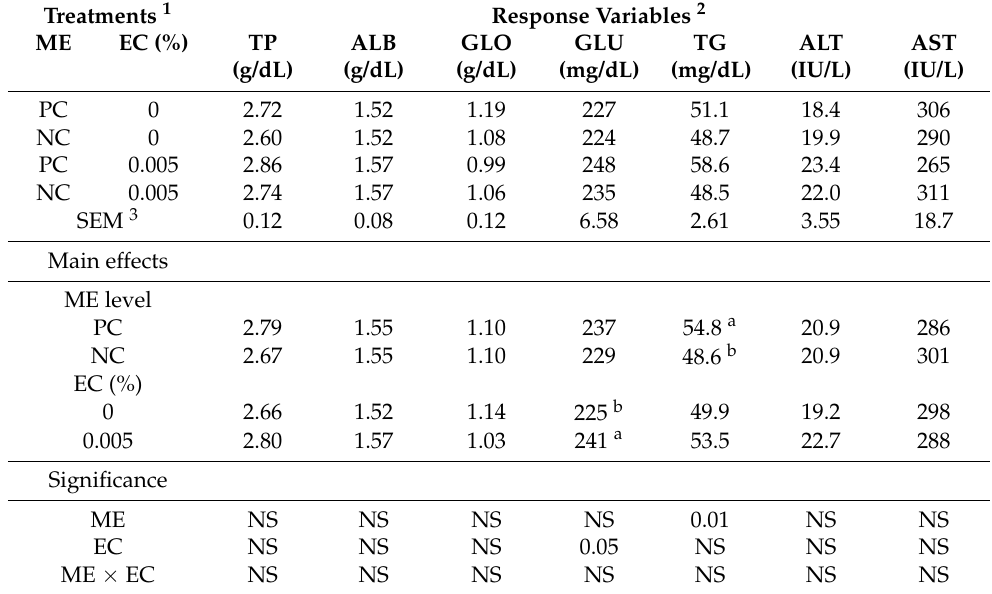
Table 6. Effect of dietary metabolizable energy (ME) level, enzyme cocktail (EC) supplementation, and their interaction on serum biochemical indices of broilers at 35